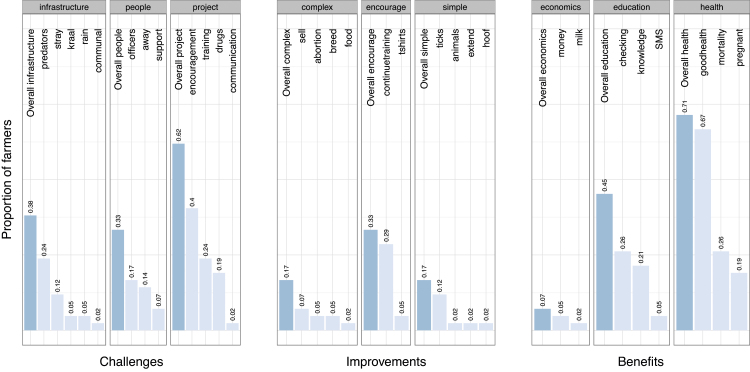
Farmer responses to feedback questionnaire, divided into three categories: Challenges faced, suggested Improvements, and Benefits gained. Responses in each category are further divided into three main groups of responses (see Table S1 for details of responses). Dark bars = proportion of farmers who gave answers in each response group overall; light bars = proportion of farmers who gave each individual response.